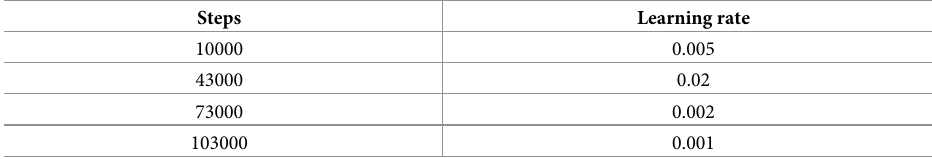
Table 4. Training hyper-parameter information.